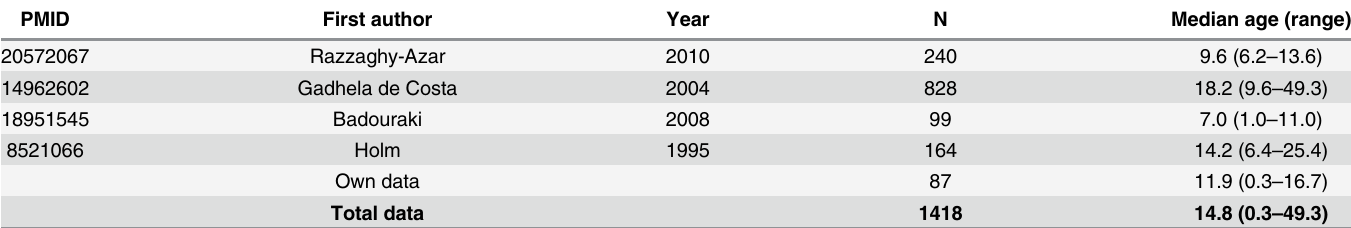
Table 1. Uterine volume data summary. Pubmed ID, first author and year of publication are given for sources of extracted data, together with number of measurements and age